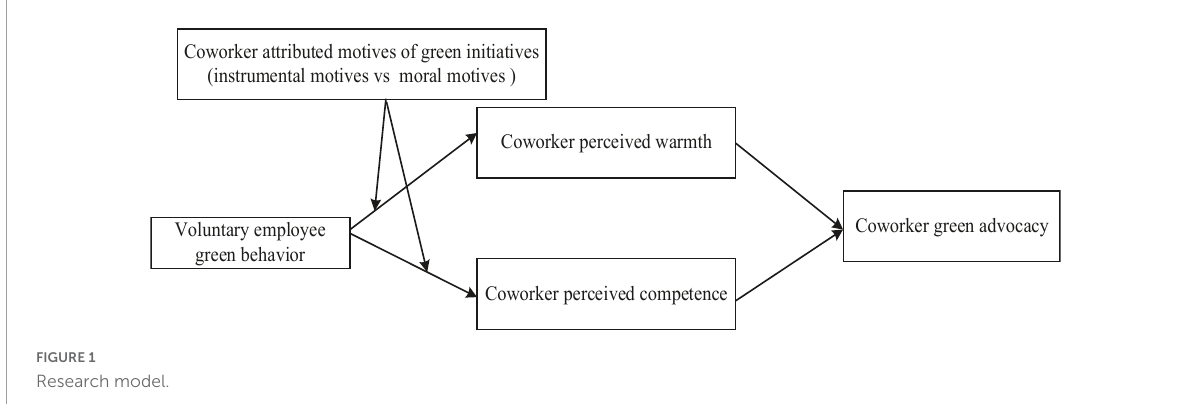
FIGURE1 Research